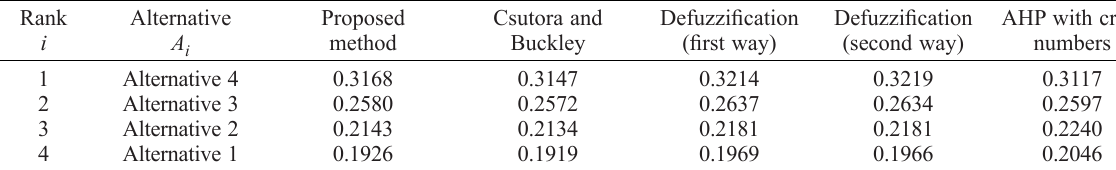
Proposed method